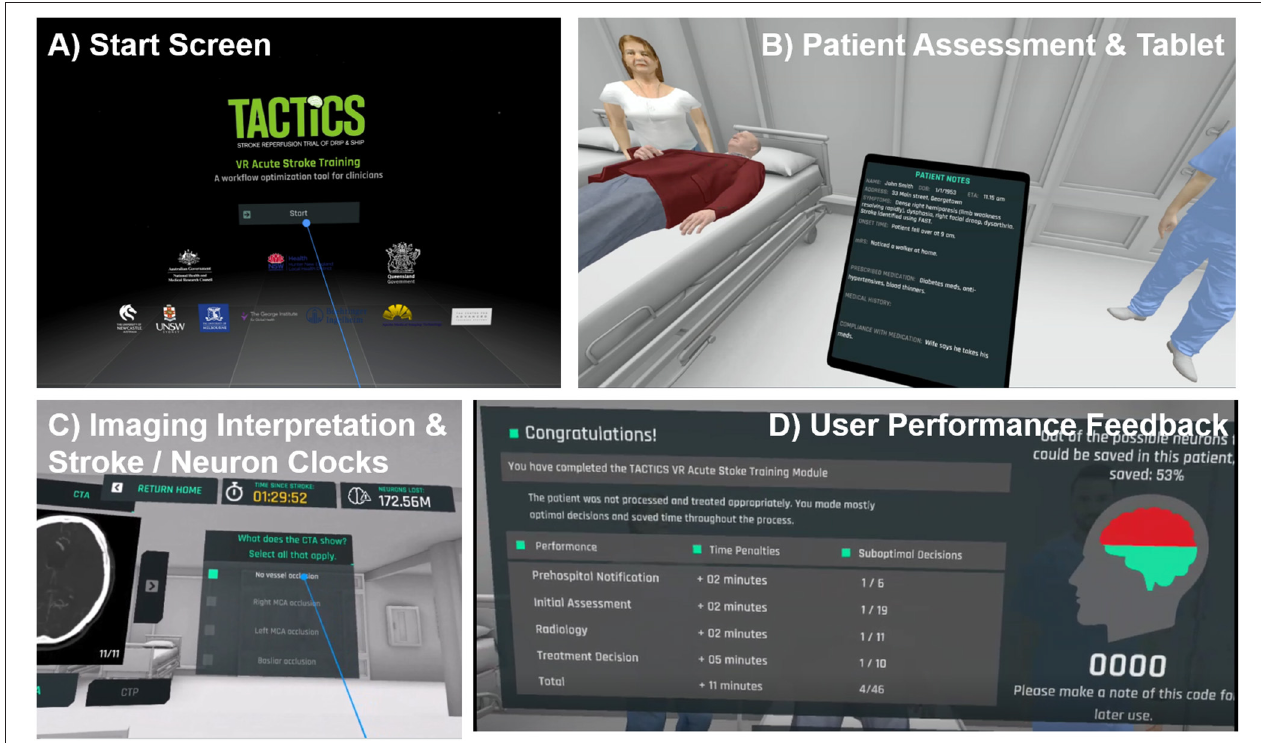
FIGURE 2 | Screenshots and key features of TACTICS VR. (A) starting scene, (B,C) representative scenes, user interactions and (D) performance